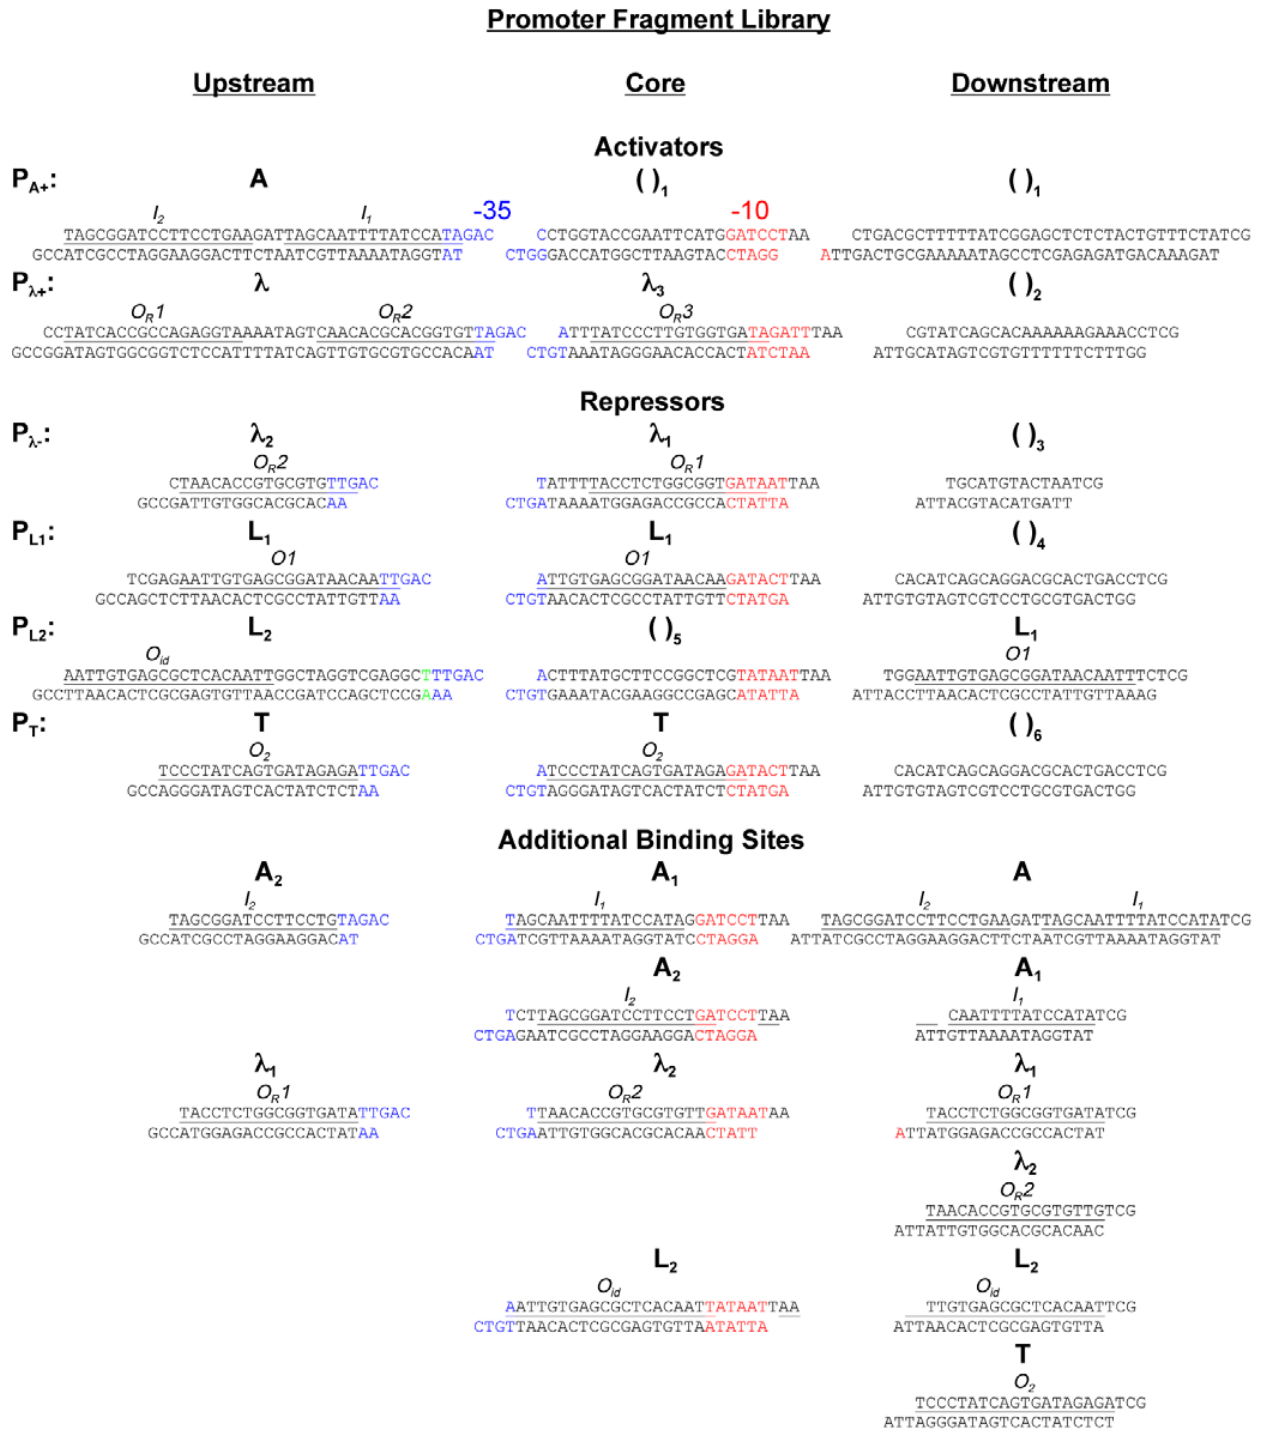
Figure 2. Promoter fragments used to construct combinatorial library. The first six rows correspond to the original promoters on which the library is based, the two activators: P A + and P l + , and the four repressors: P l - , P L1 , P L2 , and P T . Promoter fragments ‘Upstream’, ‘Core’, and ‘Downstream’ of the 2 35 (blue) and 2 10 (red) regions are displayed. Each fragment has unique three-nucleotide overhangs, allowing properly-ordered assembly upon ligation to each other and the plasmid backbone. Binding regions of specific regulators are underscored and labeled. ‘‘Additional Binding Sites’’ refers to additional promoter fragments that were created to expand the library. The lone nucleotide in green upstream of the 2 35 site in P L2 indicates the accidental insertion of a ‘T’ when we designed this promoter fragment; it has negligible effect on the strength of repression by LacI.